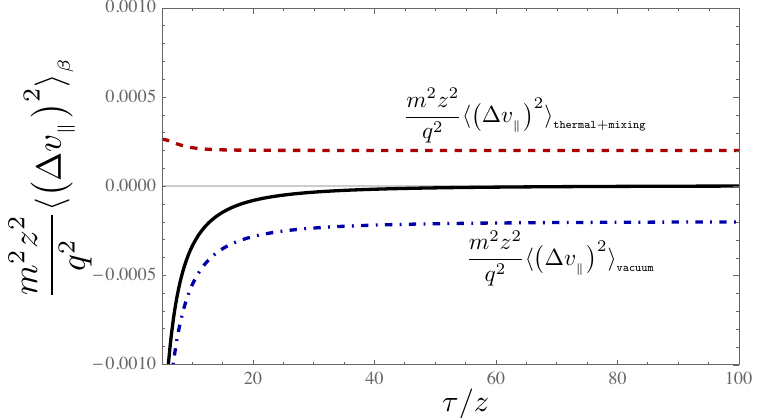
Figure 7 . The competition between positive thermal (dashed curve) and negative vacuum (dot- dashed curve) (cid:13)uctuations can produce a vanishing component of the dispersion parallel to the